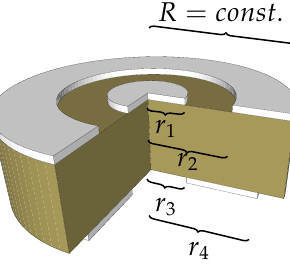
Figure 5. Parametrisation of the ring radii compared with Fig. 4. However, the change is not uniform across the parameters. Hence there is a need to find the optimal electrode configuration to ensure maximal sensitivity of the impedance to the material